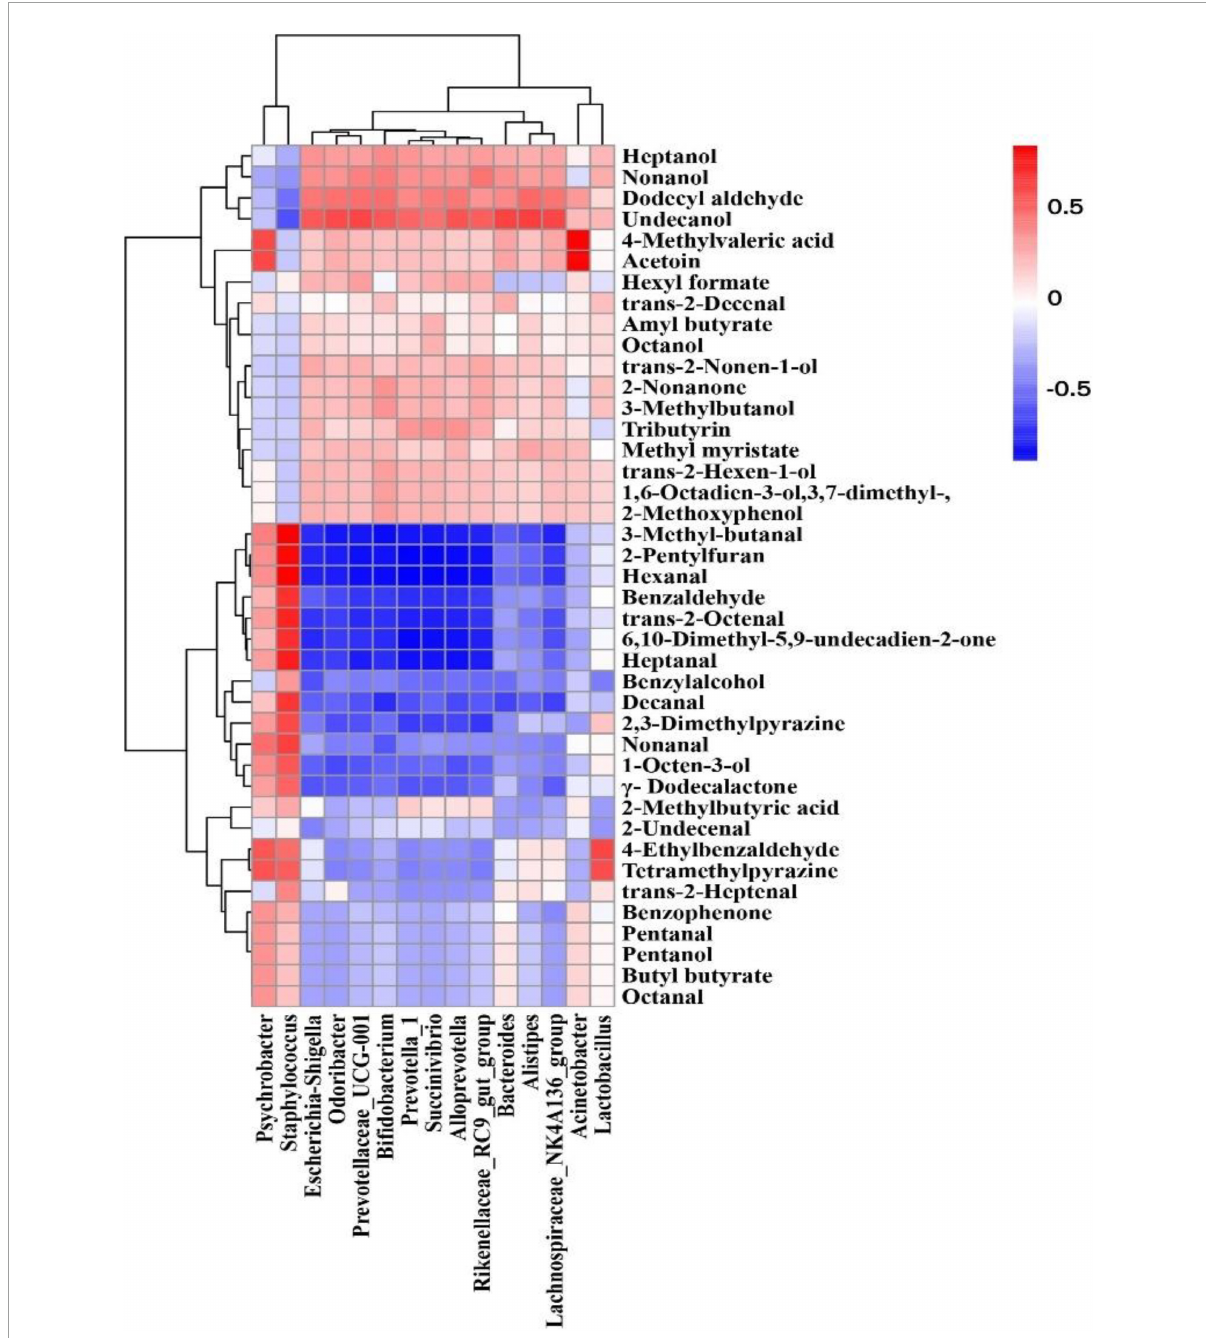
FIGURE8 A heatmap of the Spearman rank correlation between genera with relative abundance in the top 15 and the volatile properties in fermented mutton sausage during natural ripening. The intensity of the colors represents the degree of correlation between the genera and volatile compounds, where the blue color represents a negative degree of correlation and red a positive correlation.